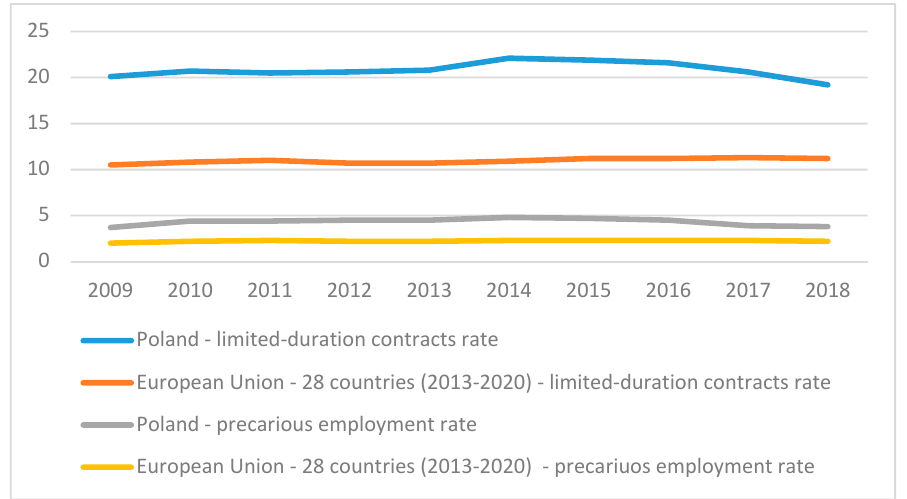
Figure 1. Poland at the background of the EU average in terms of non-standard forms of employment based on [14,15].